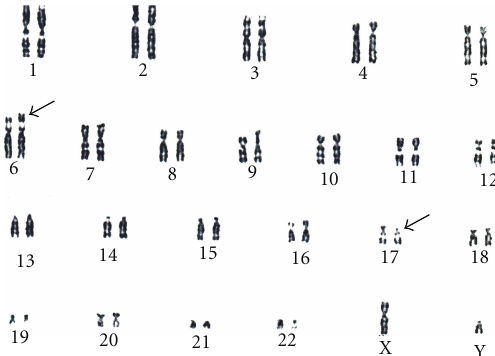
Figure 1: Karyotype of the father.